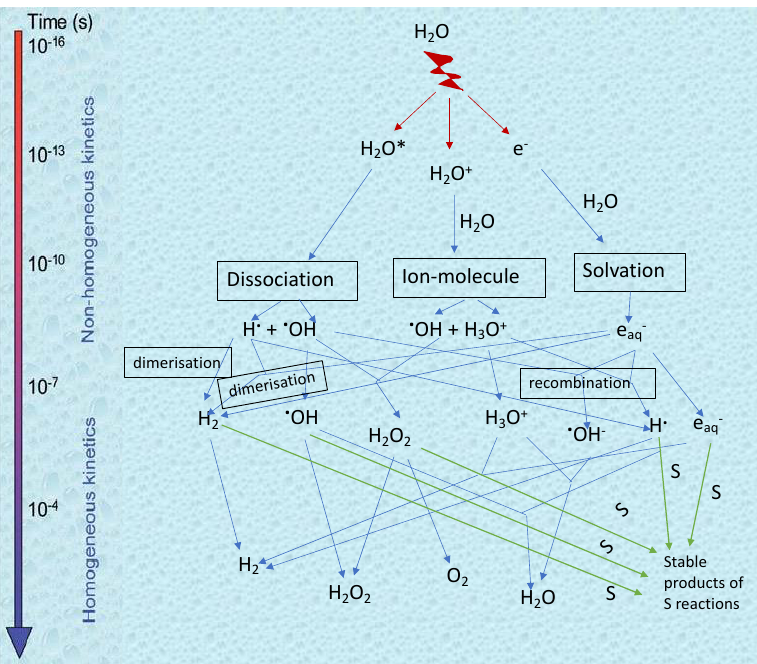
Figure 1. Scheme of reactions of transient species produced by irradiation in water without or with a diluted solute S acting as a radical scavenger. Adapted with permission from [50]; published by EDP Sciences, 2008.